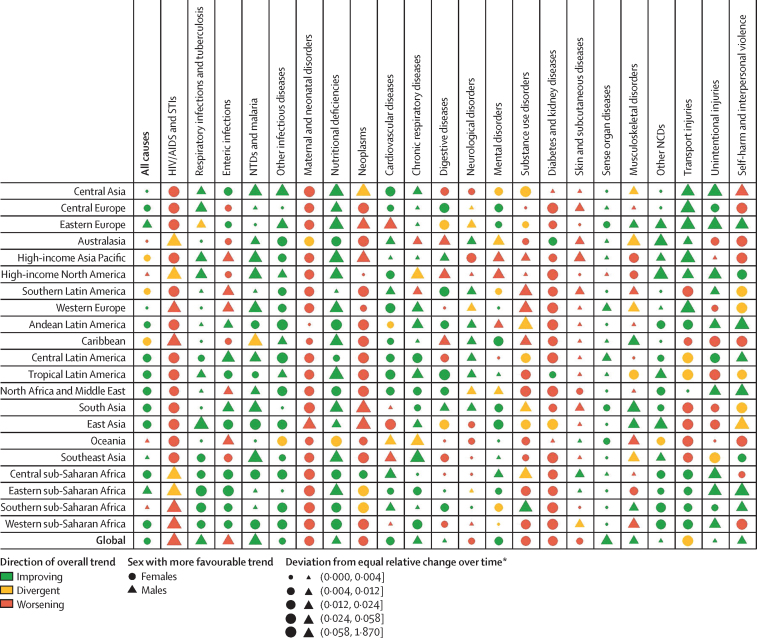
Absolute difference in non-fatal trend equality for males and females in terms of age-standardised YLD rates, 1990–2017This figure shows whether females or males experienced more favourable trends between 1990 and 2017 in terms of age-standardised YLDs by GBD region and Level 2 cause. Circles indicate females experienced more favourable trends and triangles indicate males experienced more favourable trends, where more favourable refers to either decreasing more or increasing less. Green indicates that the overall trend is improving (ie, decreasing age-standardised YLDs) and red indicates that the overall trend is worsening (ie, increasing age-standardised YLDs). Yellow indicates cause-regions where one sex is increasing and the other sex is decreasing. For example, in Andean Latin America for substance use, the large yellow triangle means that males have experienced decreasing age-standardised YLDs whereas the trend for females is the opposite (ie, increasing age-standardised YLDs). Different sizes refer to greater deviations from equal trends between 1990 and 2017. For example, for chronic respiratory conditions, males have experienced more favourable trends in both Andean Latin America and the Caribbean, with both regions having decreasing trends over time for both sexes, but the Caribbean is closer to having equal trends for males and females between 1990 and 2017. GBD=Global Burden of Diseases, Injuries, and Risk Factors Study. STIs=sexually transmitted infections. NCDs=non-communicable diseases. NTDs=neglected tropical diseases. YLDs=years lived with disability. *Round brackets indicate excluded endpoints whereas square brackets indicate included endpoints.